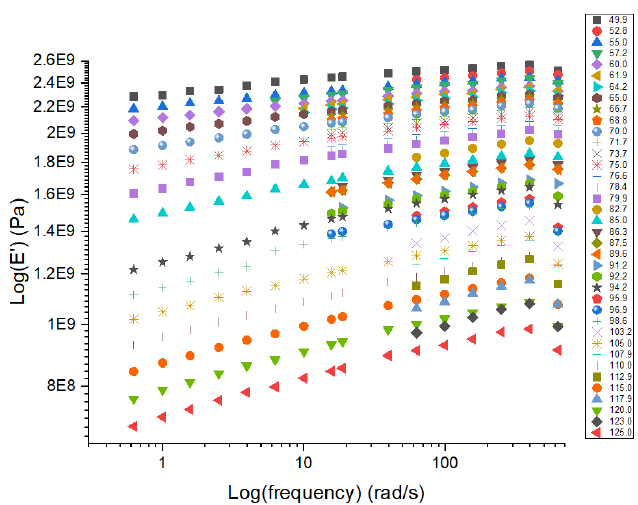
Figure 8. Storage modulus of Polymer C at various temperatures.